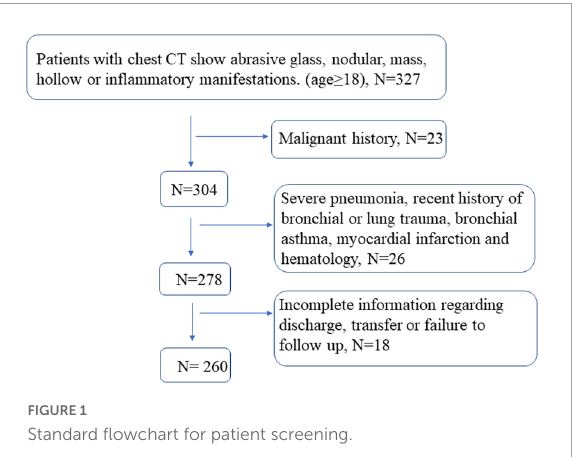
FIGURE1 Standard flowchart for patient screening.